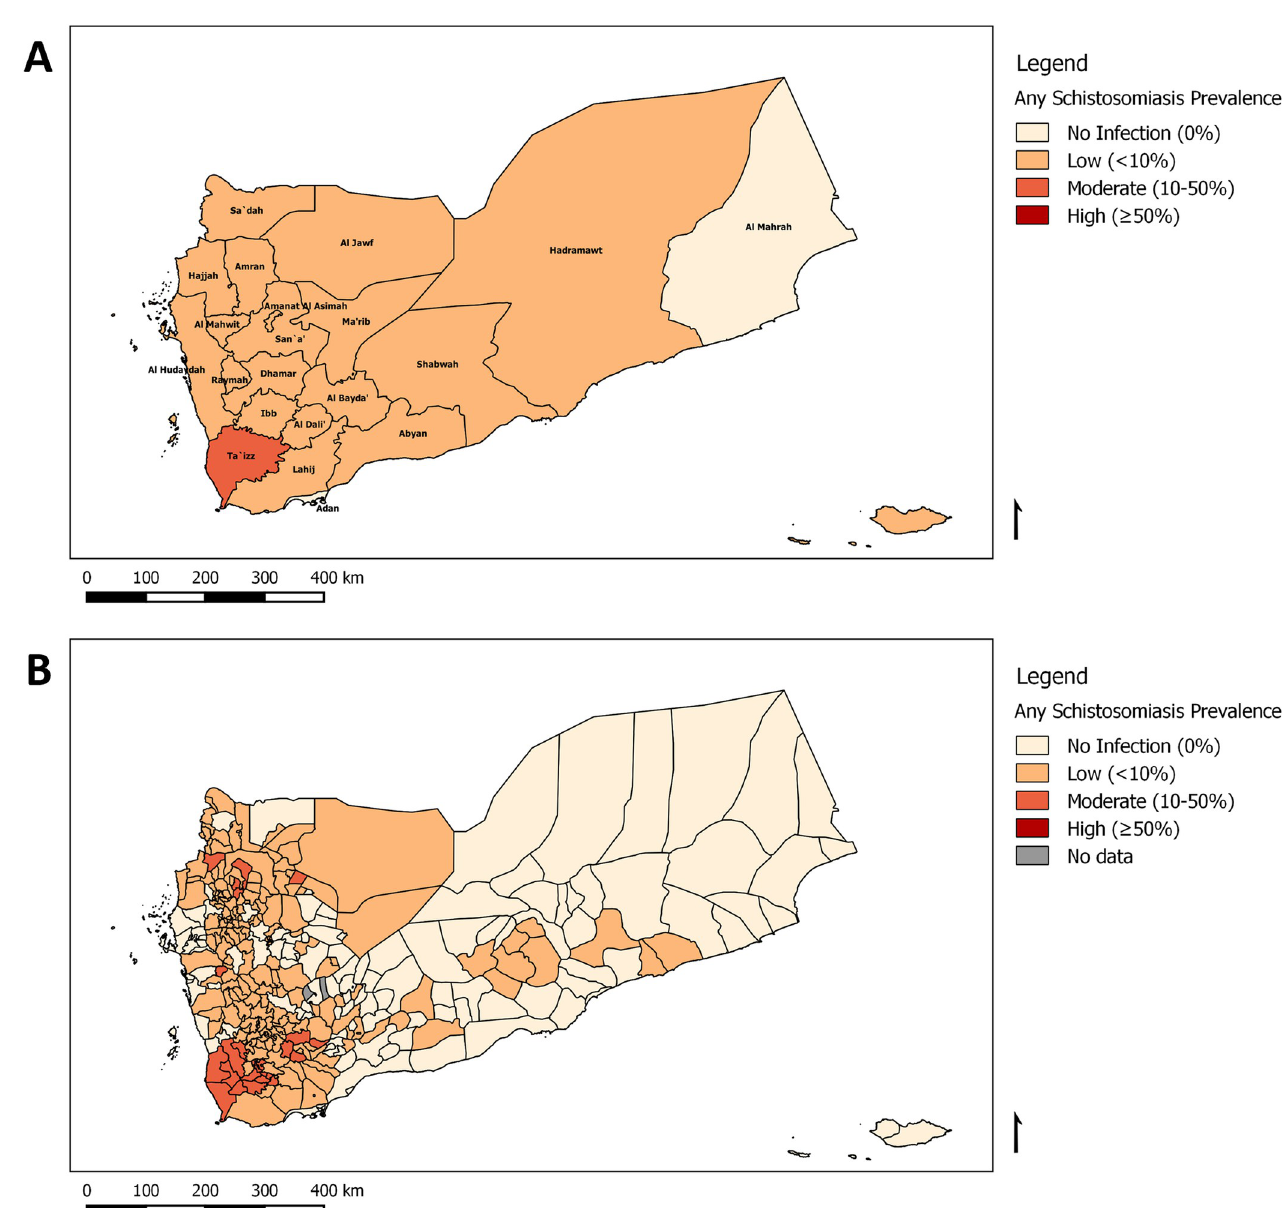
Fig 2. Prevalence of any schistosomiasis (intestinal or urogenital) infection in Yemen, 2014. The maps depict any schistosomiasis prevalence at (A) Governorate and (B) District level. These figures were created for this manuscript in QGIS using open source data from DIVA-GIS for the base layers. (DIVA-GIS-http://www.diva-gis.org/gdata).